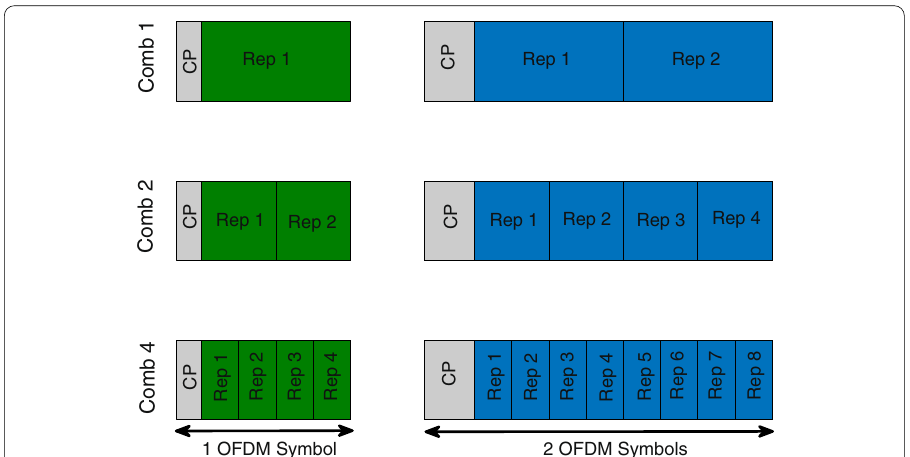
Fig. 3 Time domain resource allocation for the comb-1, comb-2, and comb-4 pilot patterns in the case of 1OS (left) and 2OS (right) RIM-RS